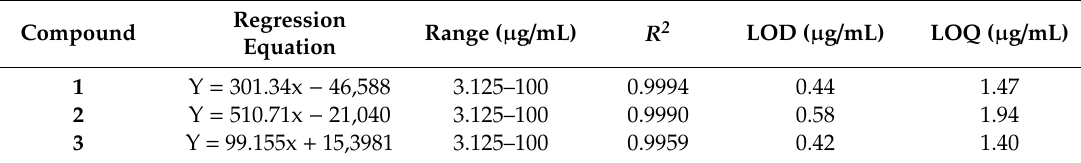
Table 1. Calibration parameters for the HPLC method.